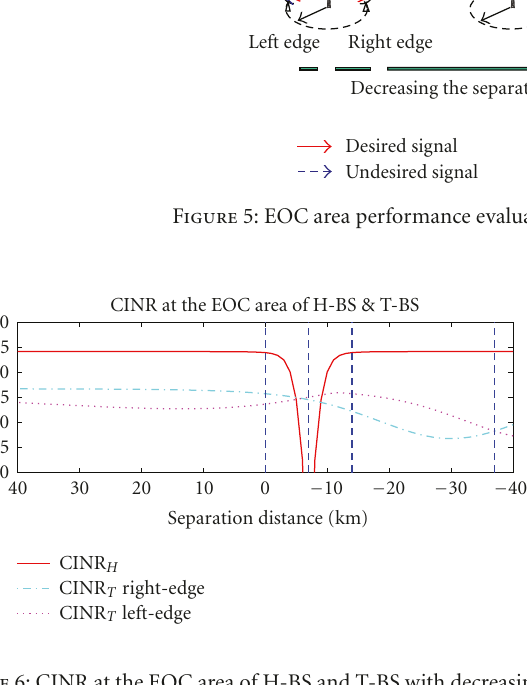
Figure 6: CINR at the EOC area of H-BS and T-BS with decreasing separation